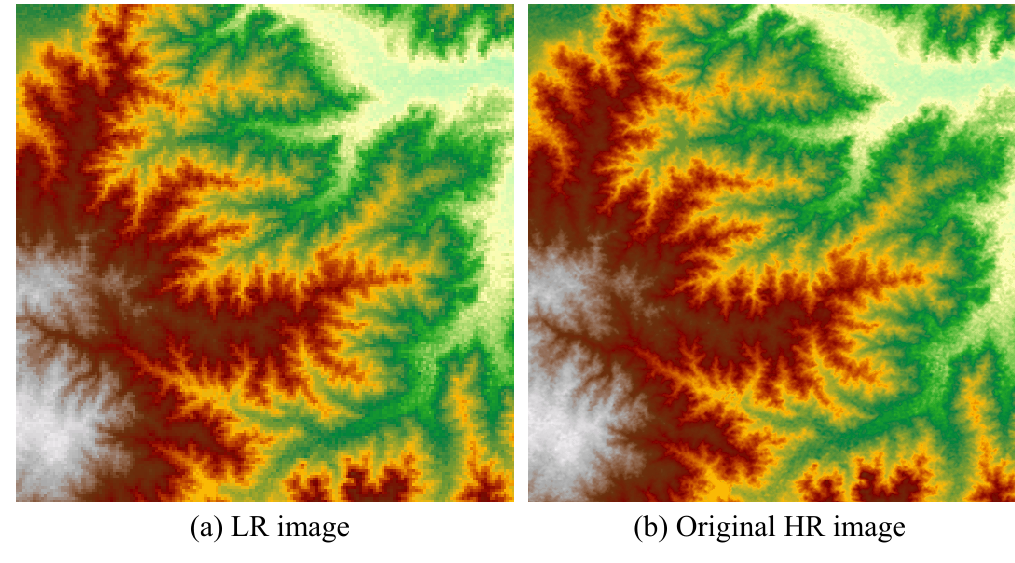
Figure 5. SRTM elevation